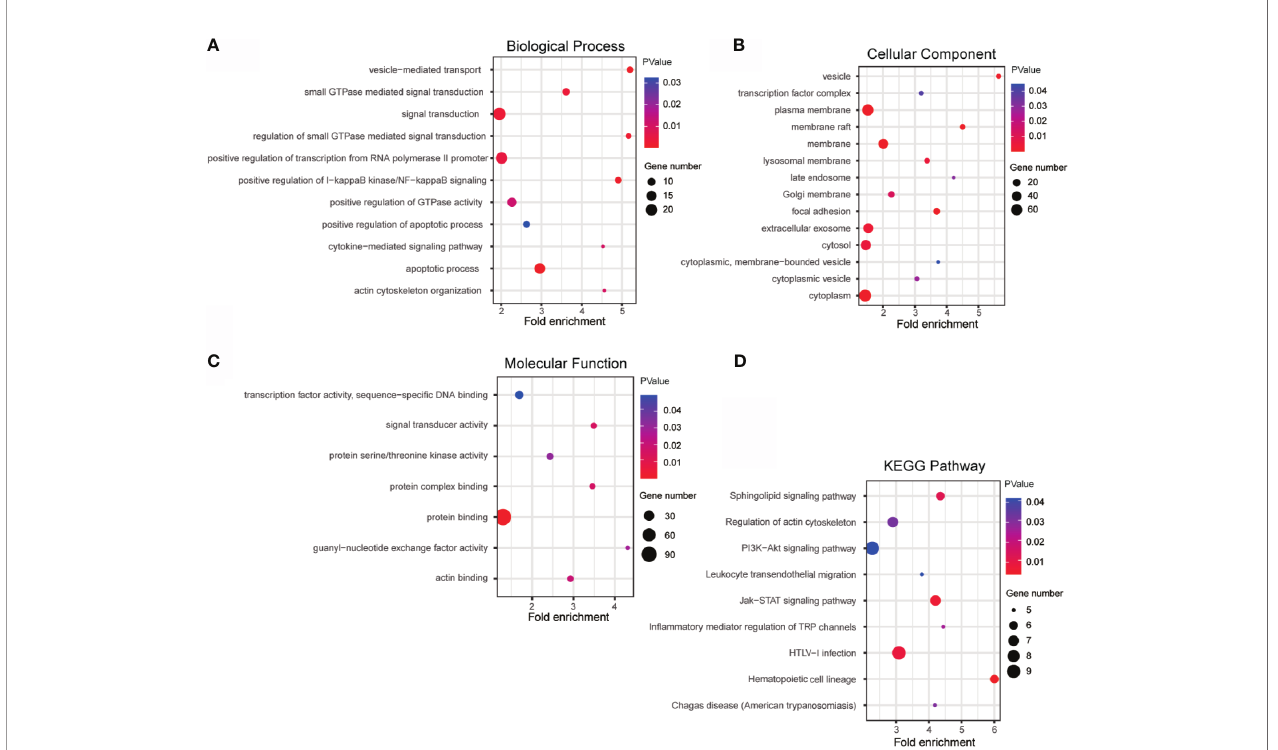
FIGURE 8 | GO and KEGG enrichment of lnc-TLCD2-1 with its co-expression genes. (A) Biological Process was mainly enriched in signal transduction, positive regulation of transcription from RNA polymerase II promoter and apoptotic process. (B) Cellular Component was mainly enriched in plasma membrane, membrane, extracellular exosome, cytosol and cytoplasm. (C) Molecular Function analysis indicated that most of co-expression genes were enriched in protein binding. (D) KEGG pathway analysis revealed that HTLV-I infection, PI3K-Akt signaling pathway and Jak-STAT signaling pathway were mainly enriched. (p value<=0.05, Gene